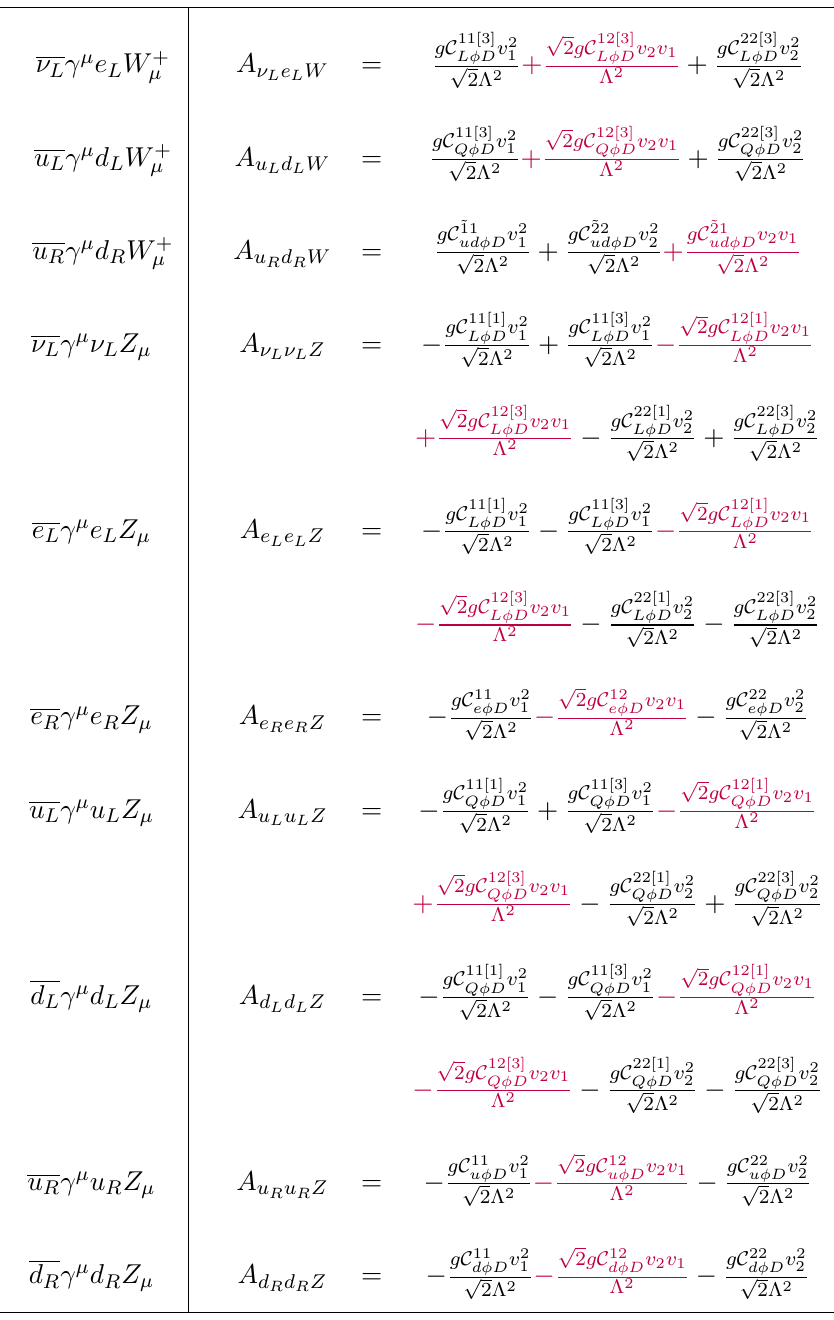
Table 28. 2HDM: corrections to gauge bosons and fermion couplings